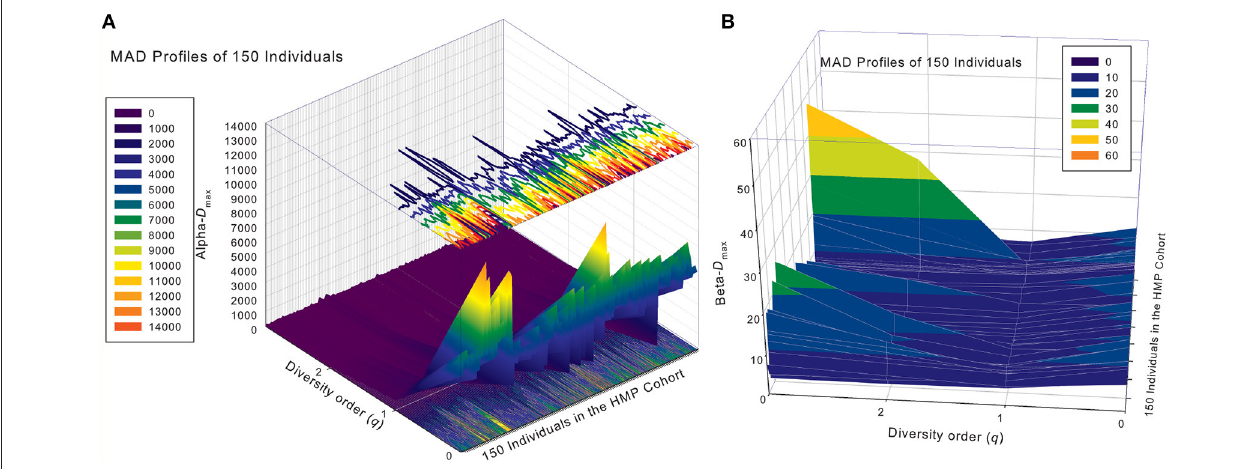
FIGURE 5 | The alpha-MAD profiles (A) and beta-MAD profiles (B) of 150 individuals in the HMP cohort: x -axis should be the subject ID of the individuals in the HMP cohort but omitted to avoid overcrowded labeling, y -axis is the diversity order ( q = 0–3), and z -axis is the alpha- or beta- D max corresponding to each diversity order ( q : y -axis) of each individual ( x -axis). In the case of alpha-MAD (A) , along the diversity order ( q ) axis, each individual has a monotonically decreasing curve (fold lines). In contrast, in the case of beta-MAD (B) , the fold lines are valley-shaped.